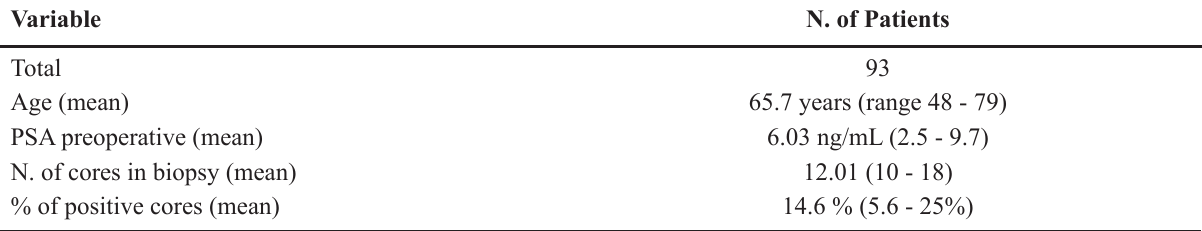
Table 2 – Demographic data.